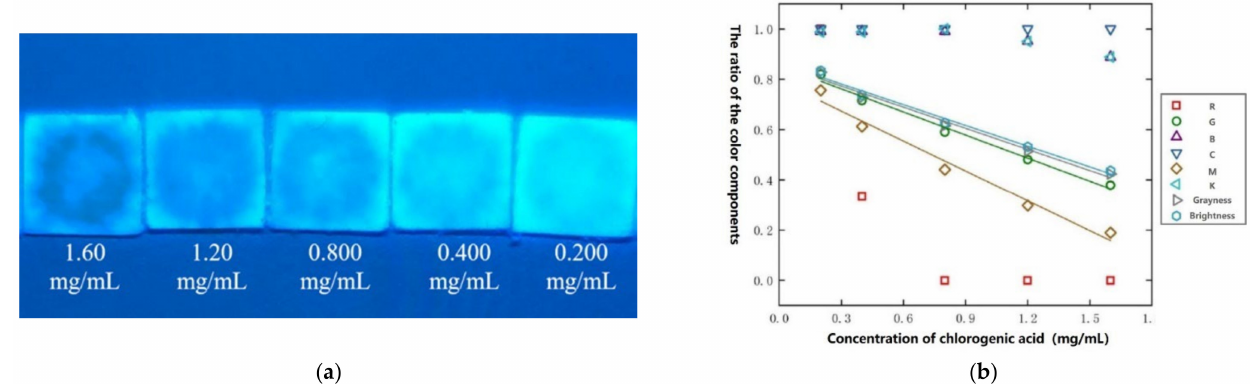
Figure 13. Comparison of two modified filter paper preparation methods. ( a ) PAD after adding differ- ent concentrations of the chlorogenic acid solution. The numbers in the graph are the concentrations of the added chlorogenic acid solution; ( b ) Relationship between the results for the ratio of different color components and the chlorogenic acid